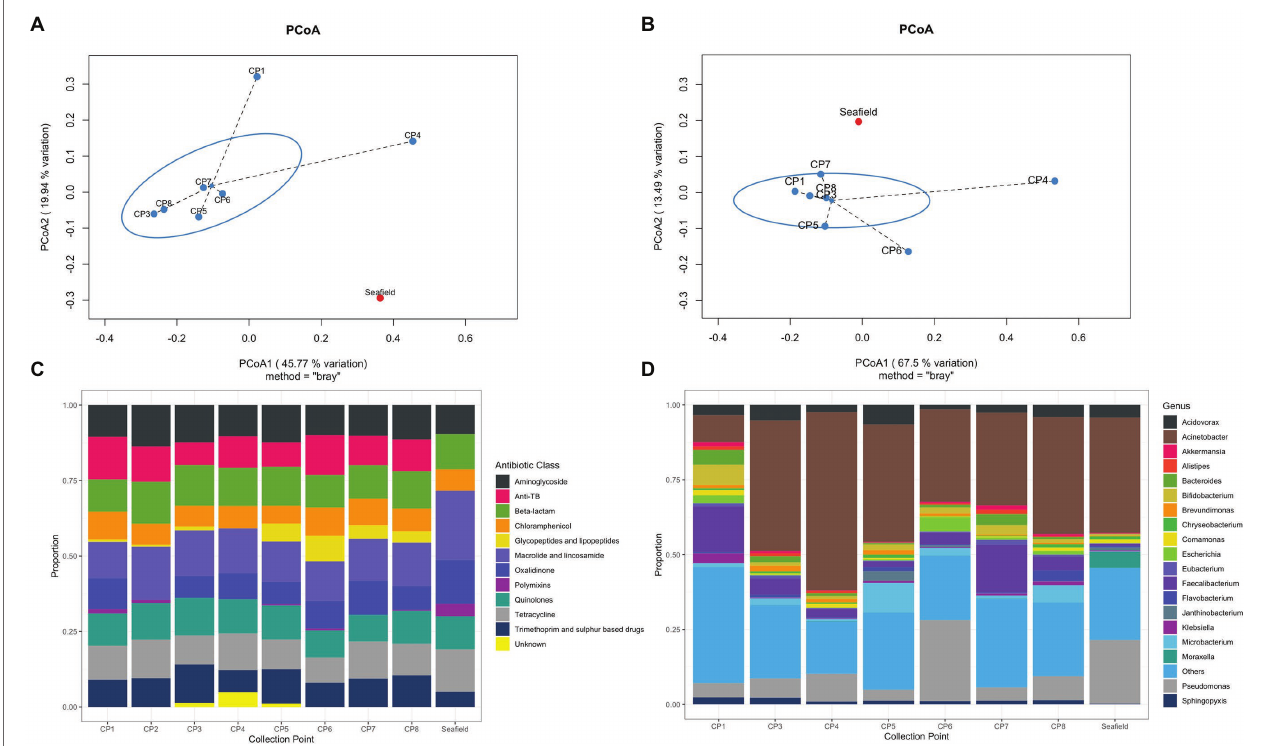
FIGURE 1 | Hospital wastewater and community sewage resistome and microbiome abundance composition. (A) Principal coordinate analyses (PCoA) of resistome based on Bray-Curtis dissimilarity. The percentage of variation explained is noted on the axis labels. (B) Principal coordinate analyses for the microbiome. (C) Relative abundance of antimicrobial resistance genes (ARGs) by antimicrobial class. (D) Relative abundance of the 19 most abundant bacterial genera in the wastewater and sewage microbiome. CP, collection point within hospital; Seafield, community sewage works; and TB,